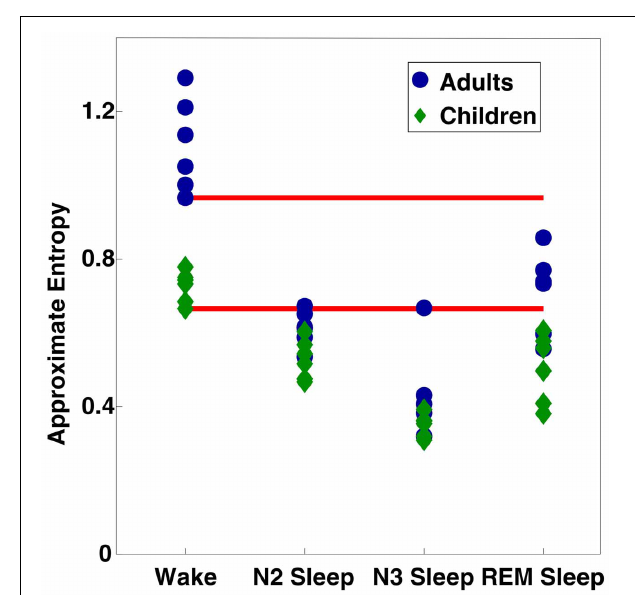
FIGURE 5 | Scatter plot of ApEn values per subject per vigilance state, averaged across all 109 electrodes. Red bars indicate the minimum values observed for each age group during